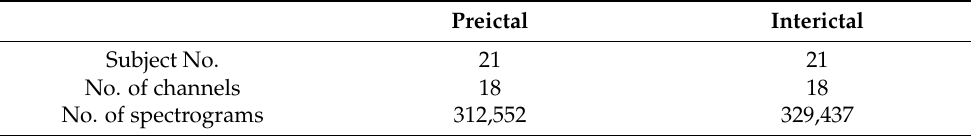
Table 2. The summary of the number of spectrograms for preictal and interictal periods.